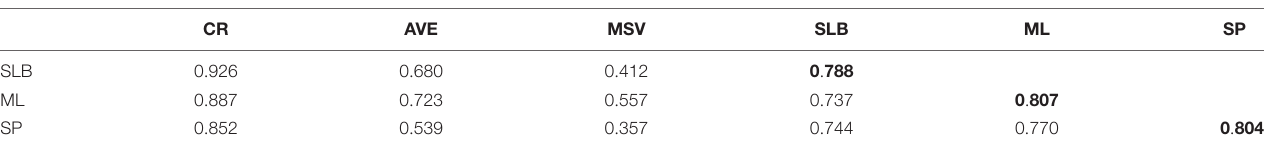
TABLE 3 | Discriminant